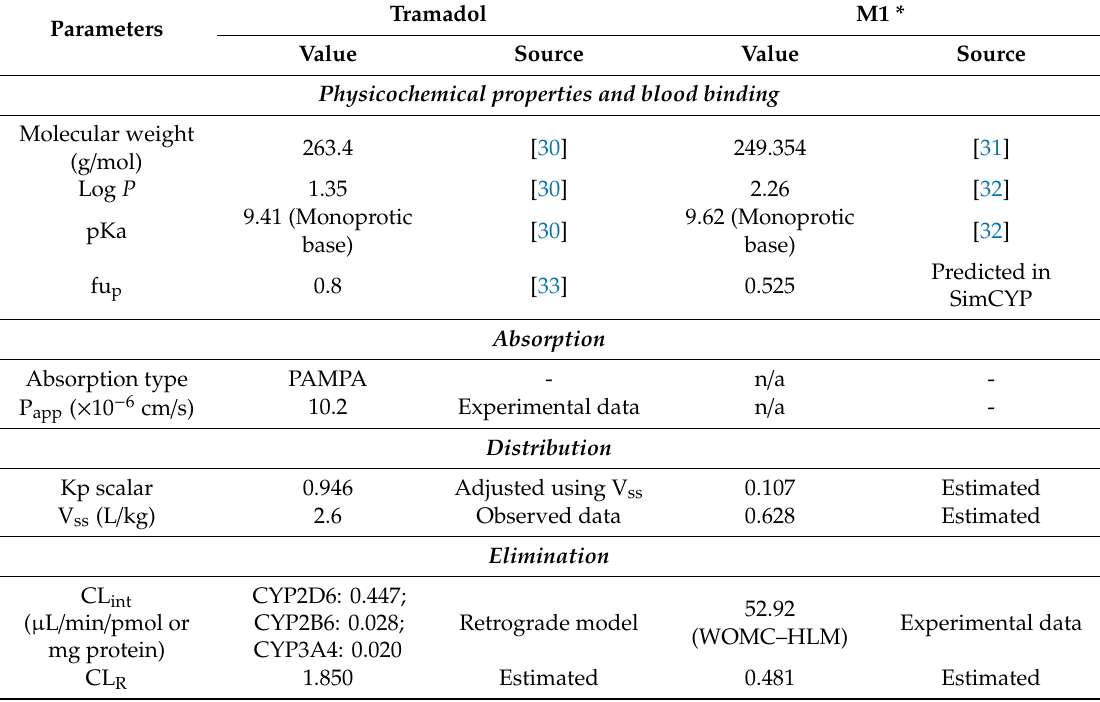
Table 2. Input parameters for tramadol and O -desmethyltramadol (M1) in the physiologically-based pharmacokinetic (PBPK) model.